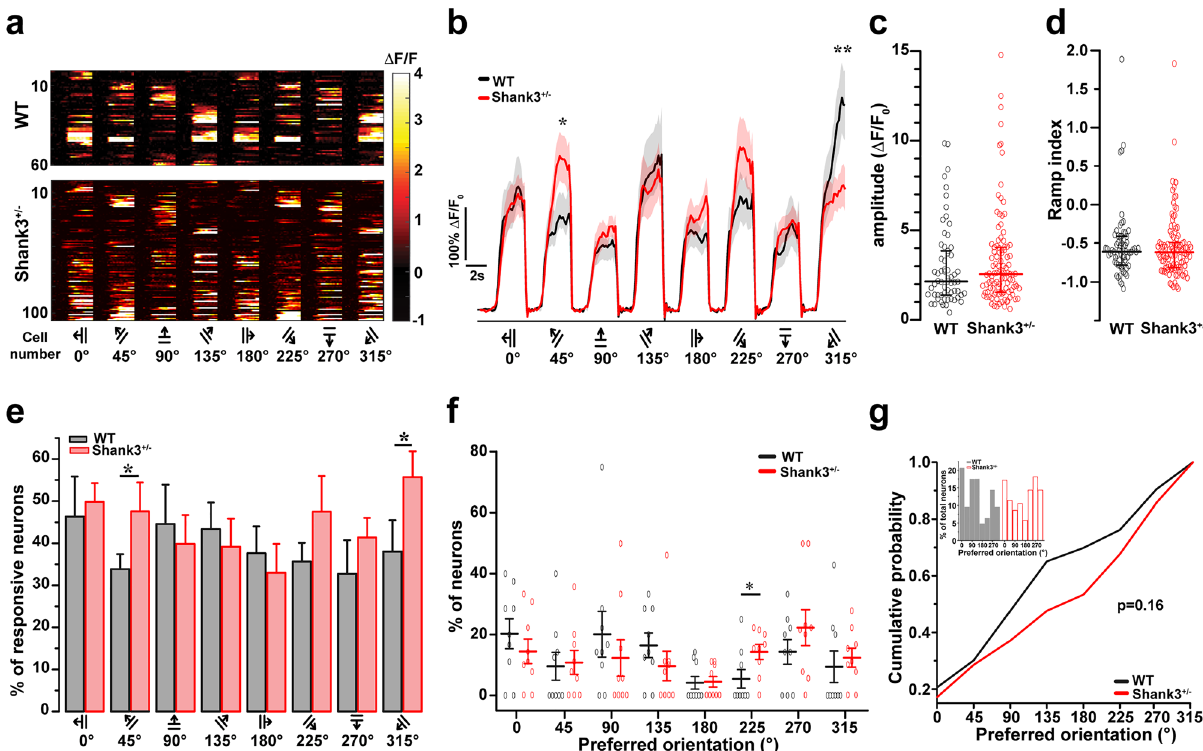
Figure 2. Neurons from Shank3 +/− respond differently to specific stimuli. ( a ) Color maps showing each responsive neuron activity evoked by visual stimulation for WT (n = 9 mice, 63 responsive neurons) and Shank3 +/− mice (n = 9 mice, 105 responsive neurons). Neurons were sorted by their intensity and their preferred stimulus orientation. ( b ) The mean neuronal activity represented as ∆F/F 0 evoked for each stimulus in WT and Shank3 +/− mice. Lines indicate the ∆F/F 0 mean values, and lighter shadings show the standard error of the mean. Two-way ANOVA revealed that there was a significant interaction between genotype and stimulus ( p = 0.0002), followed by Sidak post-hoc test; we found that neurons from Shank3 +/− mice showed significant activity differences at 45 degrees (* p = 0.017), and 315 degrees (** p = 0.003). ( c ) Response amplitude from responsive neurons in WT and Shank3 +/− mice (Basal to maximum point) (Mann–Whitney U test, p = 0.318). Represented as median + IQ range. ( d ) Ramp index from WT and Shank3 +/− (Mann–Whitney U test, p = 0.594). Represented as median + IQ range. e ) Proportions of responsive neurons for each stimulus. Student’s t-test, * p = 0.046 for 45° and * p = 0.043 for 315°. Bars indicate means ± SEM. ( f ) Percentage of neurons with preferred